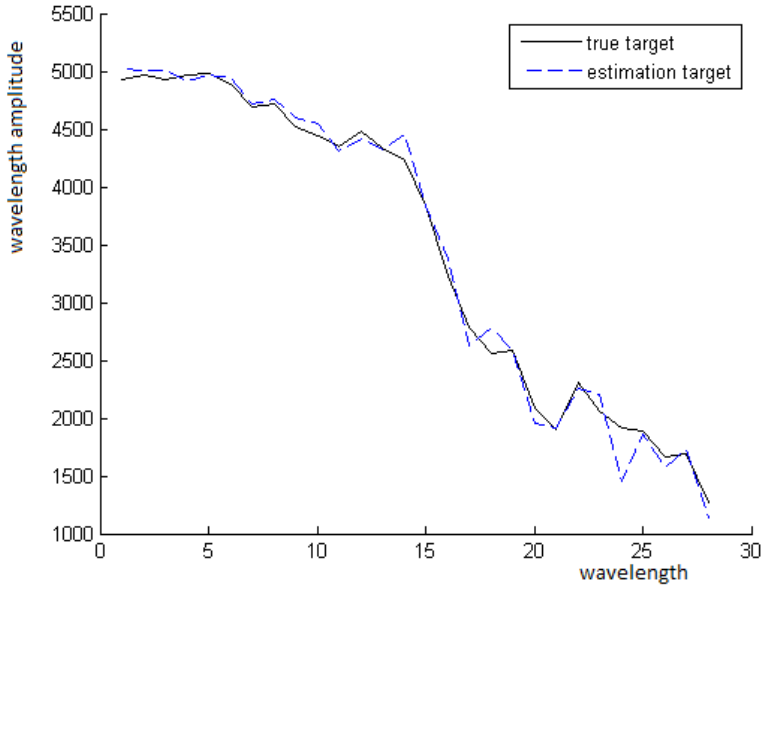
Figure 8. The solid line corresponds to the real spectrum of the background and the dotted line corresponds to the estimated spectrum of the